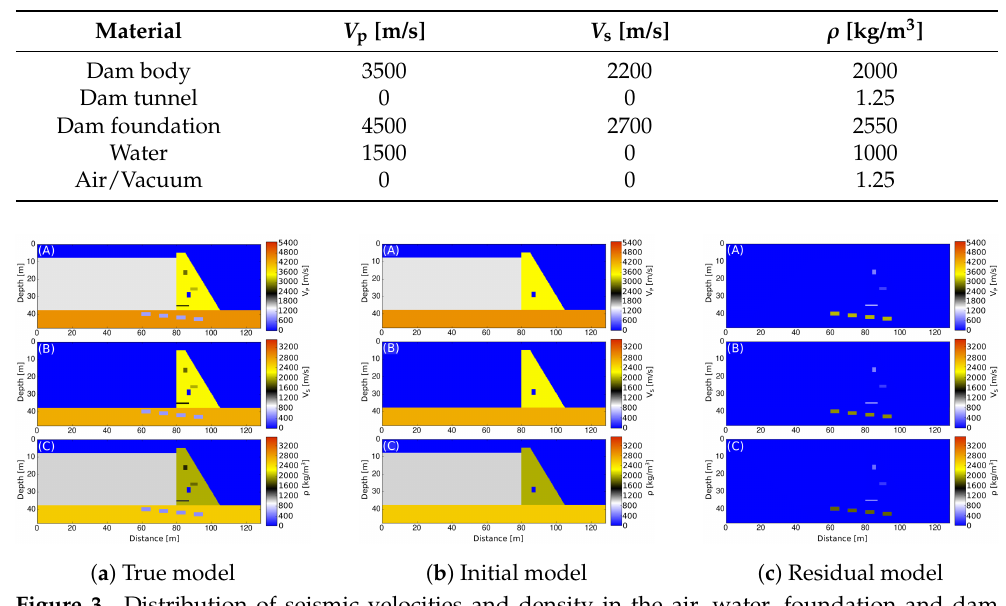
Table 1. Dam material properties for true model.